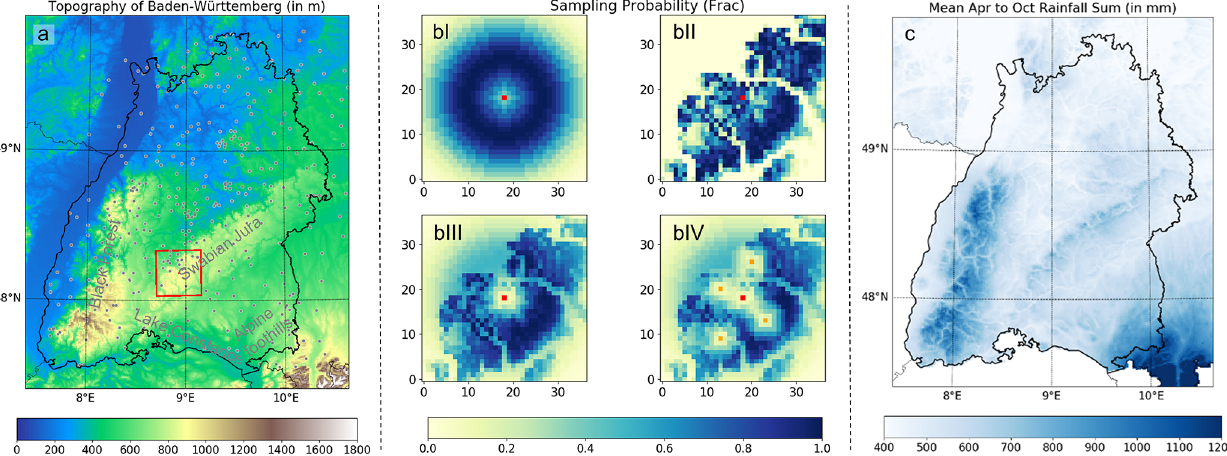
Figure 1. (a) Topography of Baden Württemberg (BaWu) as well as location of the precipitation gauges used in the BW-Stat dataset and some of the geographical regions referred to in the text. (b) Probability for a specific radar cell to be sampled based on the distance to cell of interest (bI) , orography (bII) , and orography and distance combined (bIII) . Final sampled cells (orange) and reduced probabilities around the selected cells are depicted in panel (bIV) . All panels reflect the area indicated with a red square in (a) . The respective cell of interest is marked in red. (c) April to October rainfall sum (1991 to 2020) of the REGNIE (Regionalisierte Niederschlagshöhen) dataset compiled by the German Weather